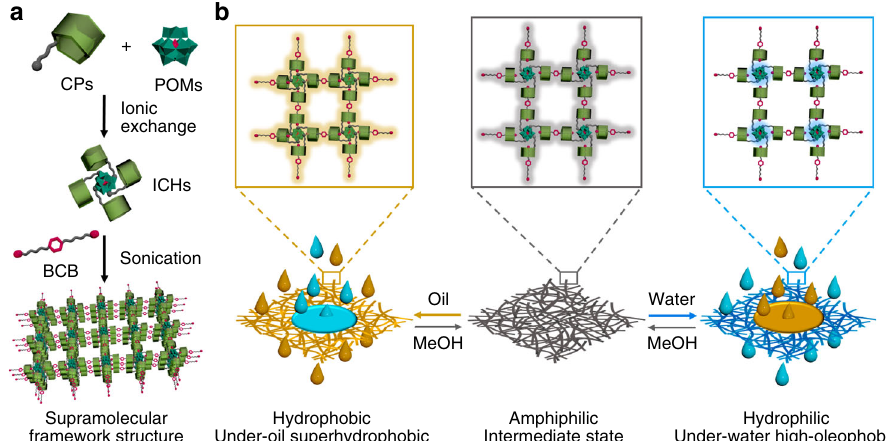
Fig. 1 Supramolecular framework assembly in gel membrane for switchable liquid separation. a Schematic formation of supramolecular framework driven by pre-ionic and post host – guest interaction, where CPs denotes cationic pillar[5]arenes, ICHs means the ionic complex hosts. b Modulation of membranes via intermediate state (gray) for changing over in oil (yellow) and water (blue)